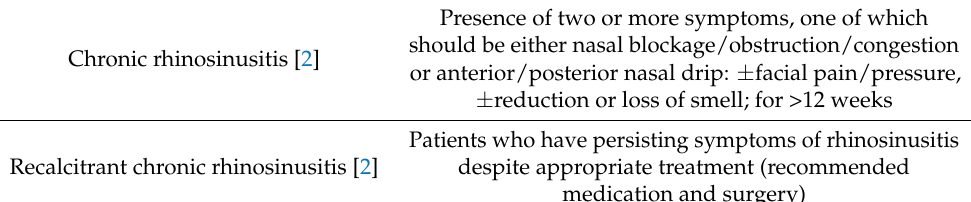
Table 1. Definition of chronic rhinosinusitis and recalcitrant chronic rhinosinusitis, according